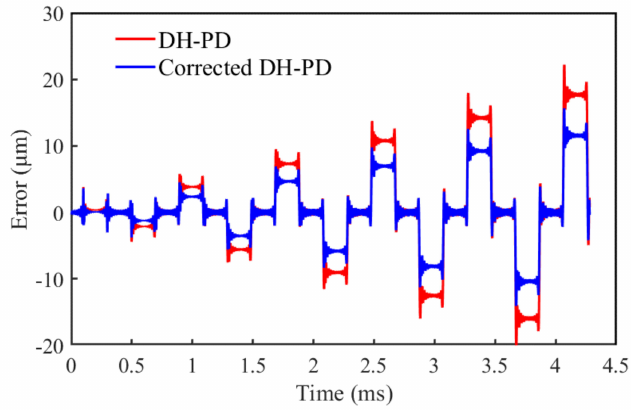
Figure 9. Errors of the DH-PD model with and without